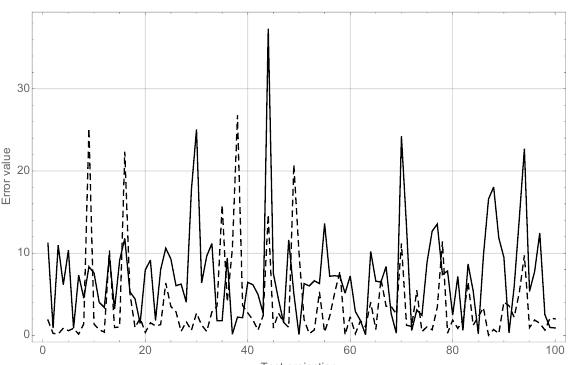
Figure 5. Results of the angle estimation tests for the ‘Cars’ category: in the solid line, the module of the error series for λ angle, and in the dashed line, the module of the error series for the φ